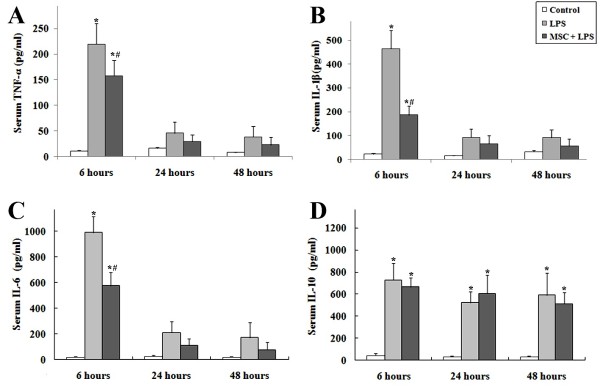
(A-C) LPS caused a significant acute systemic inflammatory response as early as 6 hours. Administration of UC-MSCs reduced pro-inflammatory cytokines at each time point. (D) LPS also caused an increase of anti-inflammatory cytokine IL-10, but this change was not altered by intravenous administration of UC-MSCs (*, p < 0.05 compared with healthy controls; #, p < 0.05 comparing LPS plus UC-MSCs with LPS alone).